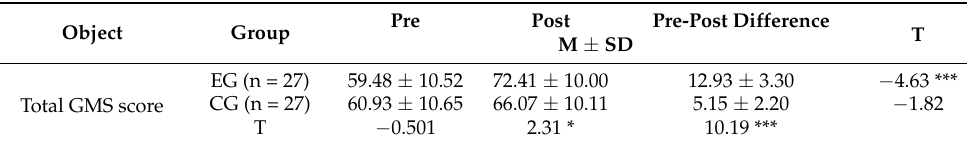
Table 7. Comparison of total gross motor skills pre- and post-test scores between the female preschooler EG and CG. Pre Post Object Group